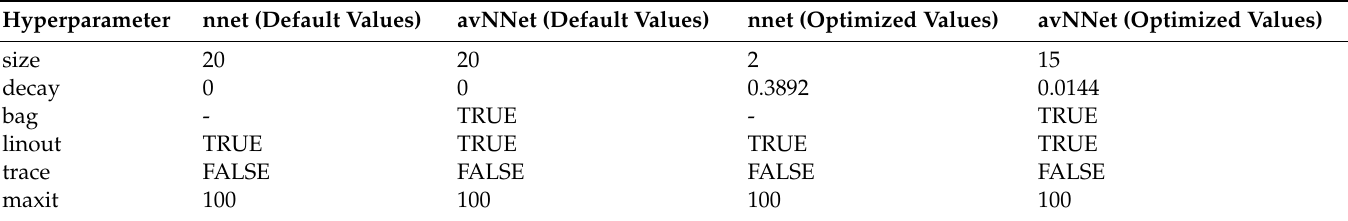
Table 9. The specific hyperparameters of neural